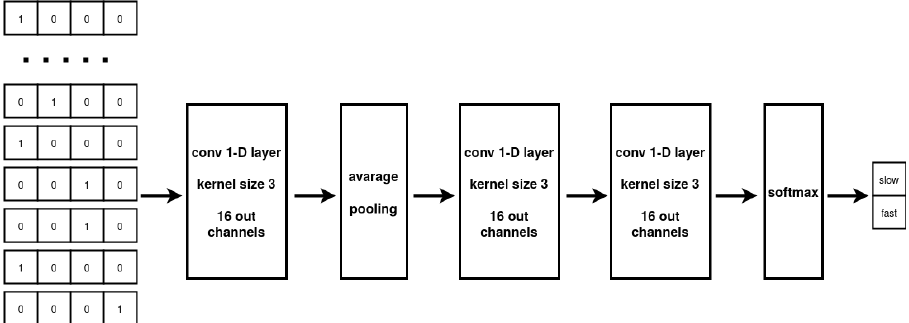
Figure 6. The 1-D CNN exploited for sequence